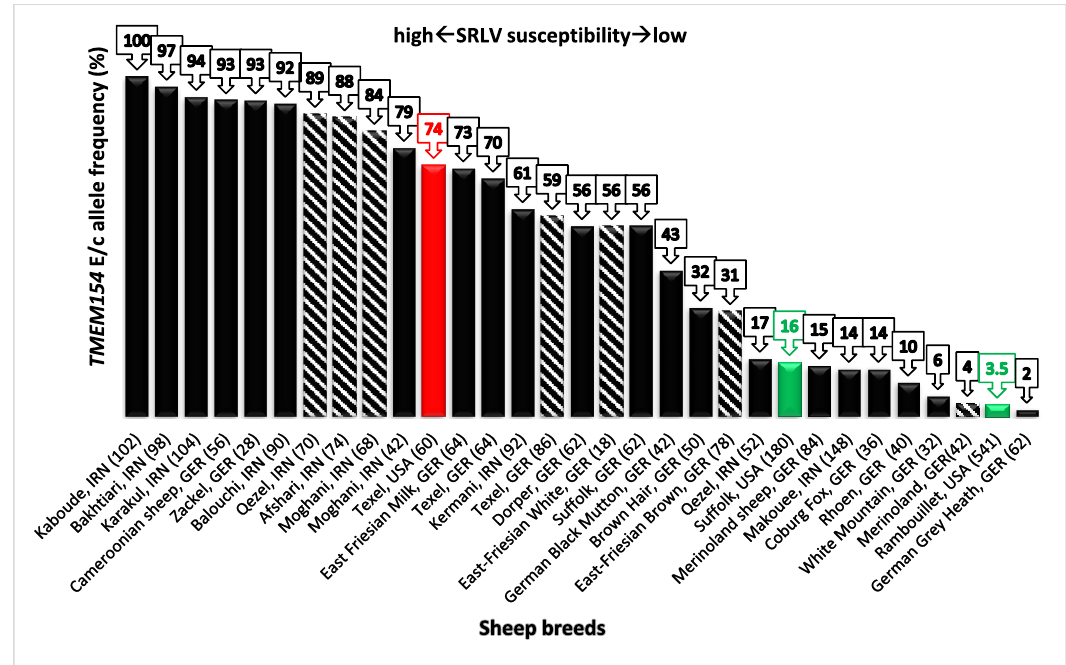
Figure 2. The degree of susceptibility to SRLV infection in nine sheep breeds from Iran (IRN) and fifteen sheep breeds from Germany (GER) is shown based on the frequency of the TMEM154 E allele (solid bars, present study) or the c allele of SNP OVAR17-5388531 (shaded bars). The c allele is in linkage disequilibrium with the E allele. The c allele frequencies derived from 50K SNP chip data (International Sheep Genomics Consortium, ISGC). Colored solid bars indicate certain US sheep breeds with known SRLV susceptibility based on epidemiological data [12] (red = high susceptibility, green = low susceptibility).